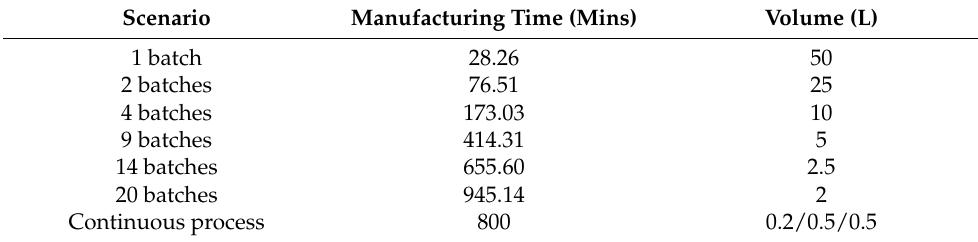
Table 1. Optimized batch number, Manufacturing time and batch capacity.